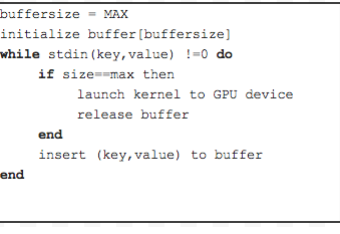
Fig. 5. Pseudocode of Map Function in JCuda Approach